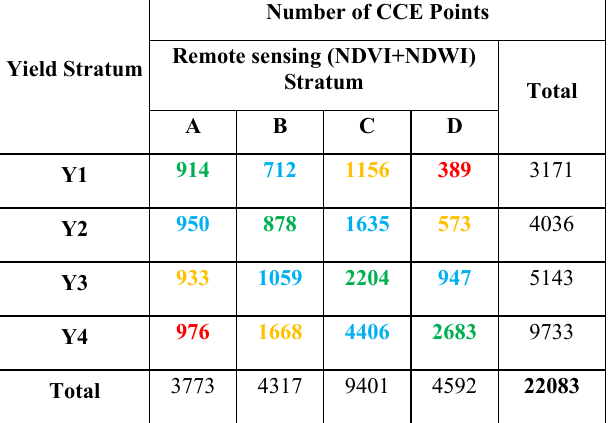
Table 2: Comparison of CCE points between yield and remote sensing stratum